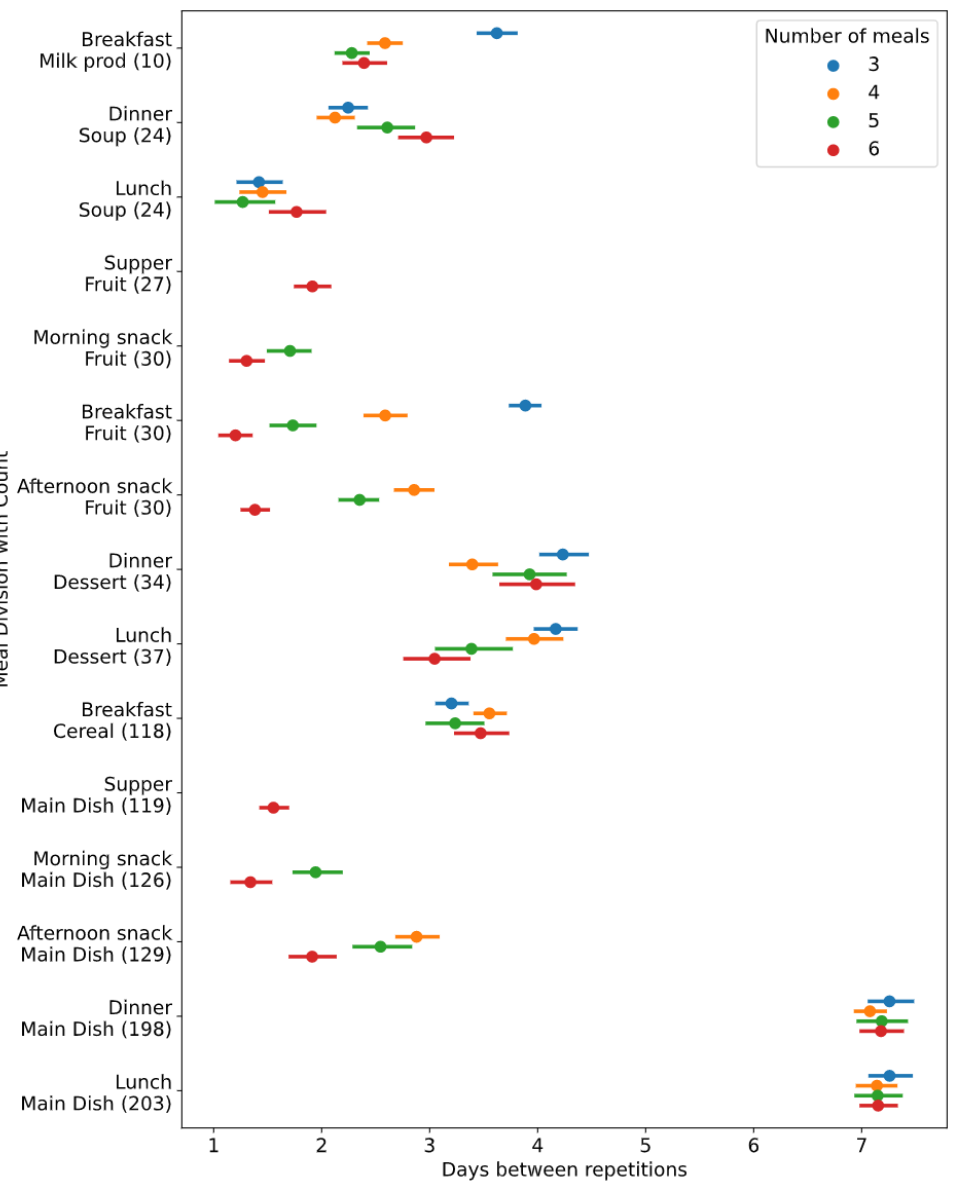
Figure 5. Plot of the number of days between repetitions in the meal plans and the different meal divisions sorted by the number of available recipes inside